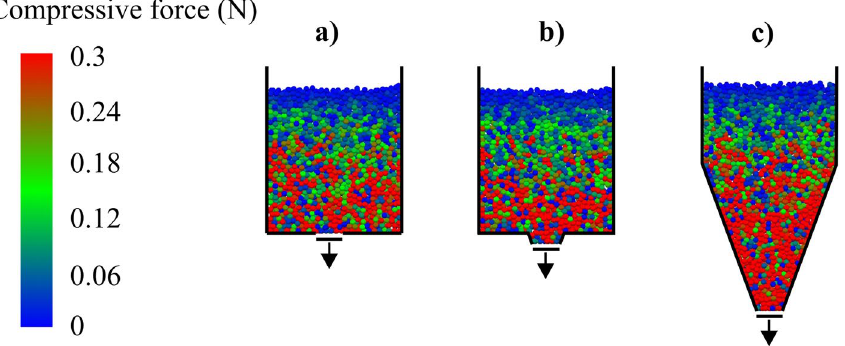
Figure 2. Visualization of the contact forces between particles in the middle slice of model silo at rest: ( a ) flat orifice, ( b ) converging orifice, ( c ) hopper with the same α as that of the converging orifice.